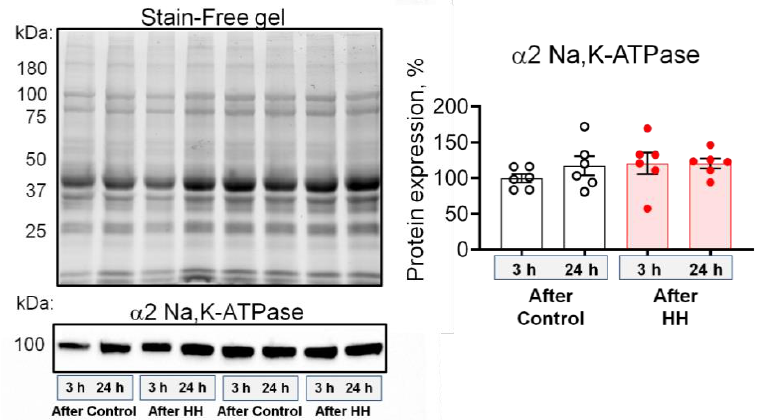
Figure 7. Exposure to hypobaric hypoxia (HH) at a pressure equivalent to an altitude of 3000 m for 3 h does not affect the total α 2 Na,K-ATPase content in the rat diaphragm muscle. The measurements were carried out on muscles isolated 3 or 24 h after control or HH treatment. Left —representative total protein load detected with Stain-Free gel and Western blots for the α 2 Na,K-ATPase, used for semi-quantification of its protein expression. Right—the averaged results of semi-quantification of the α 2 Na,K-ATPase expression. The number of muscles corresponds to the number of symbols. Two-way ANOVA followed by Bonferroni multiple comparisons